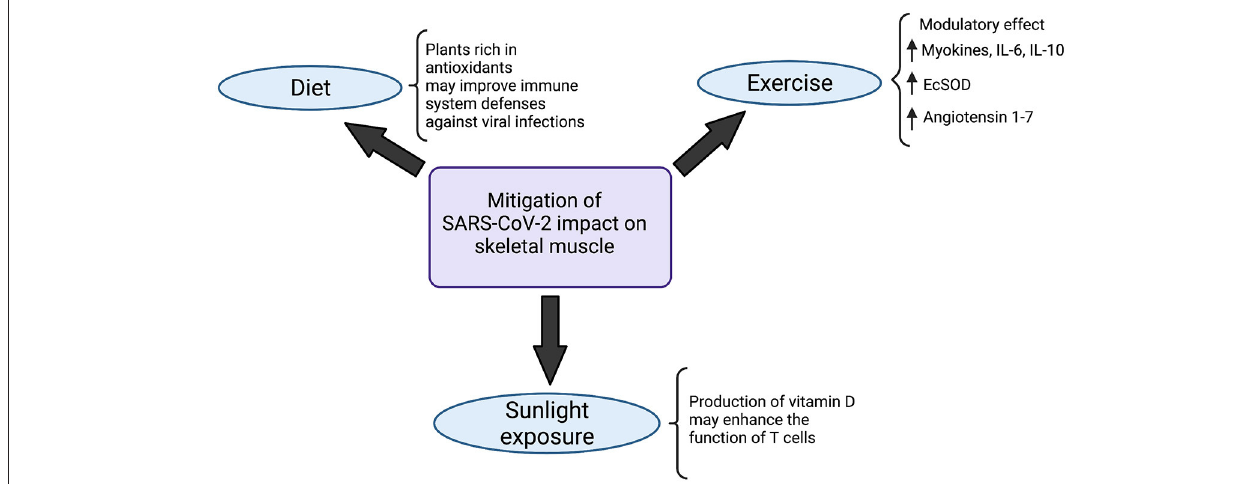
FIGURE 3 | Strategies to mitigate SARS-CoV-2 impact on the musculoskeletal system. Diet modifications, sunlight exposure and exercise have been indicated in the literature as potential strategies to minimize the impacts of SARS-CoV-2 on skeletal muscle. Meals rich in antioxidant plants likely boost defenses of the immune system, improving viral infections combat. At the same time, the production of vitamin D, triggered by exposure to sunlight, enhances the function of T cells. Physical activity, on the other hand, exerts a modulatory effect in the organism, mainly characterized by a state of increase in myokines, IL-6 and IL-10, which improves the body’s immunovigilance. Augmented expression of antioxidant Extracellular Superoxide Dismutase enzyme (EcSOD) has also been detected during exercise, which contributes to both oxidative stress and tissue damage reduction. Angiotensin 1-7 also seems to be upregulated in the setting of physical activity, which plays a role in mitigating the deteriorating effects of SARS-CoV-2 in the organism. Created with Biorender.com.